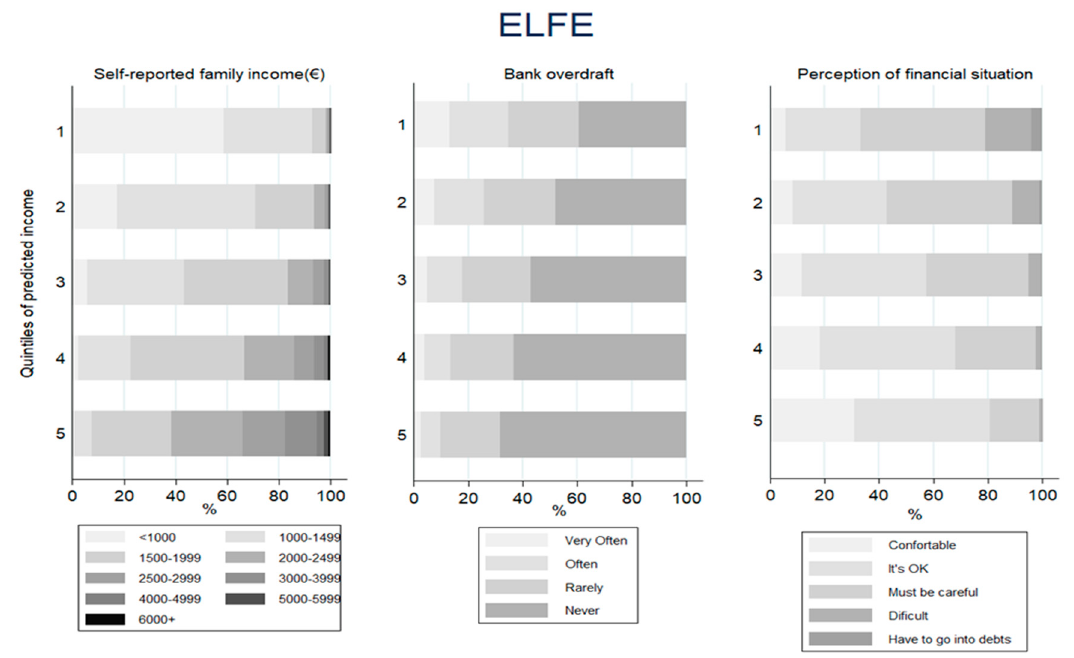
Figure 3. Distribution of the SEP-related variables available in the ELFE cohort by quintiles of the predicted income.